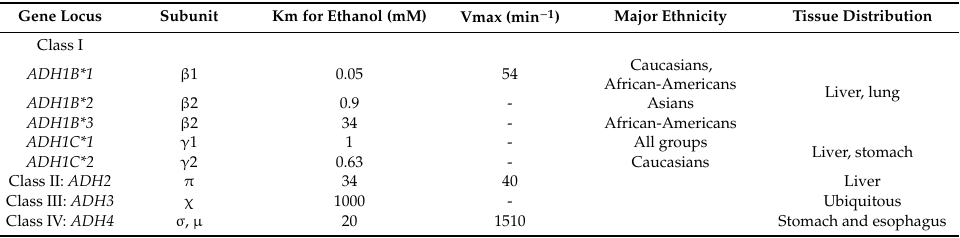
Table 1. The kinetic properties of each ADH class, population, and tissue distribution [23,29]. Gene Locus Subunit